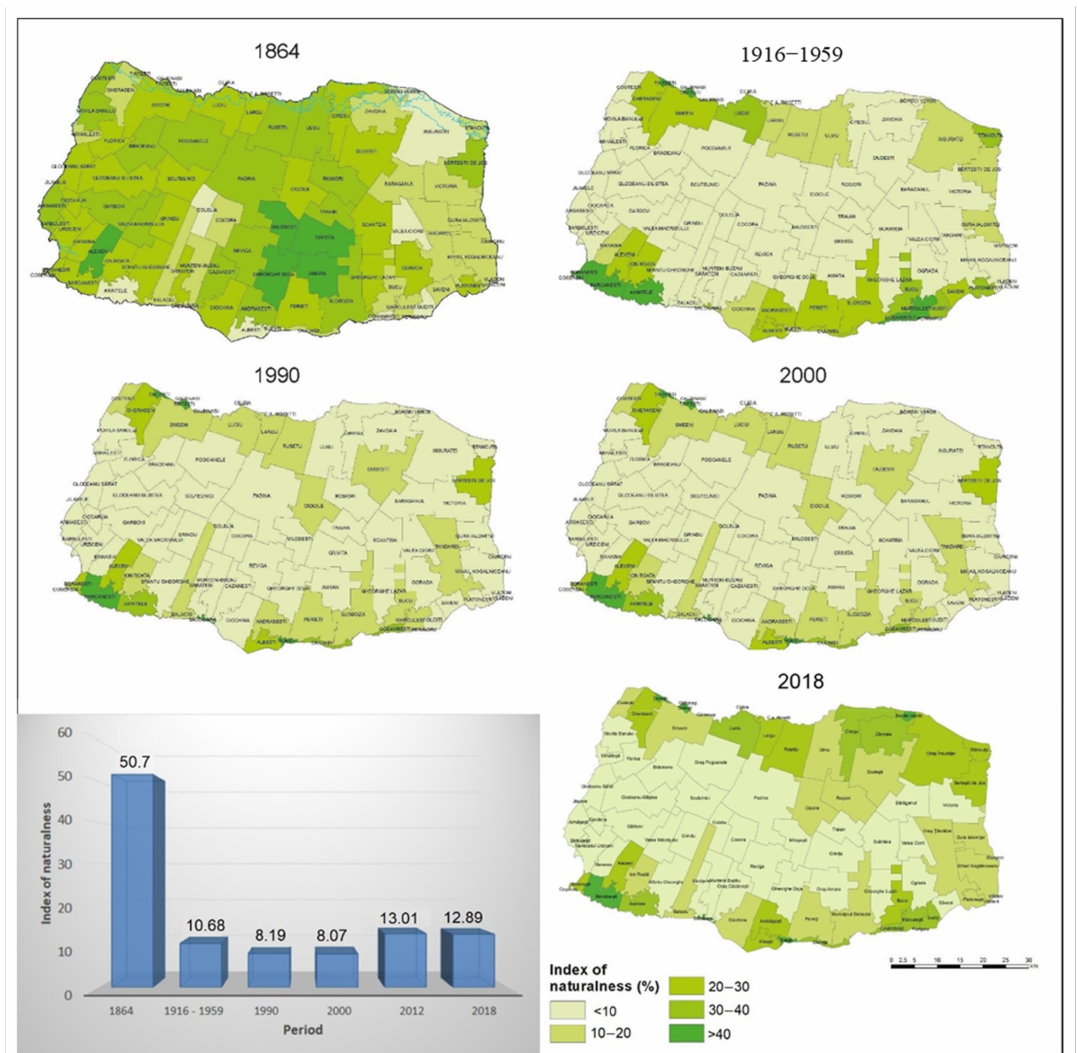
Figure 6. Index of naturalness for the years 1864, 1916–1959, 1990, 2000, 2018, in Central B ă r ă